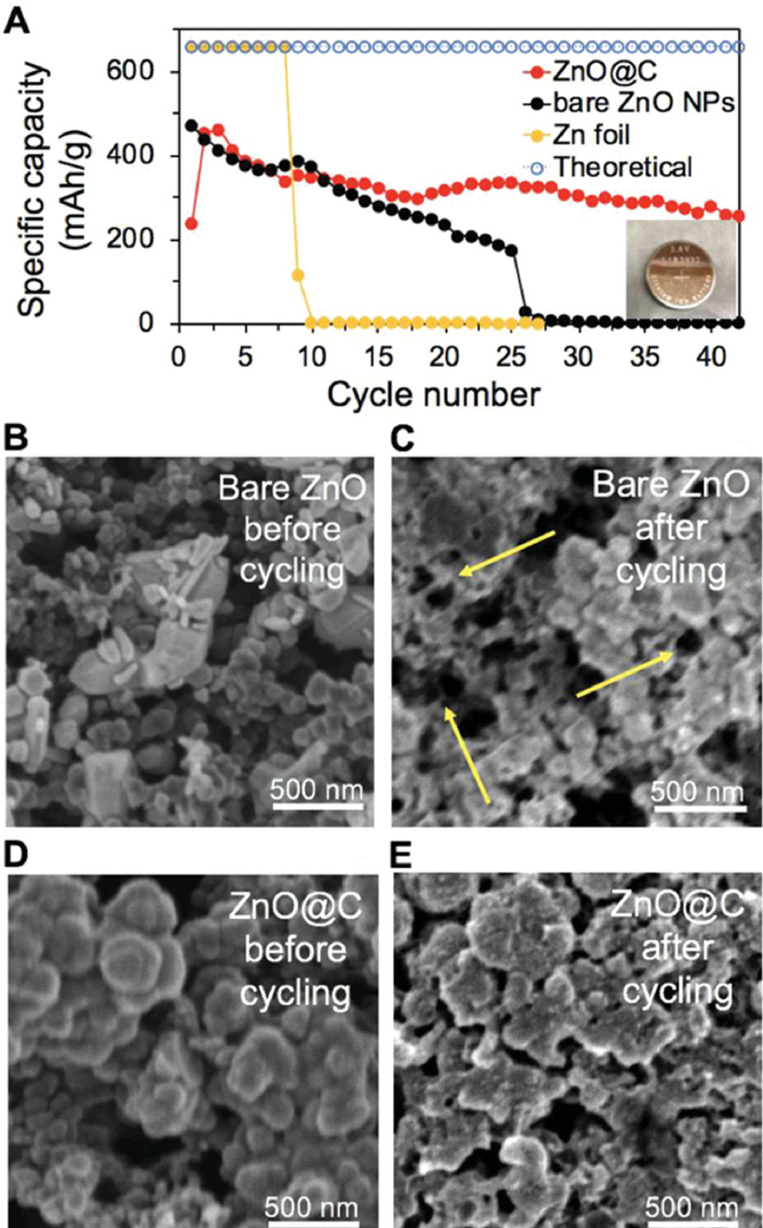
Figure 9. ( A ) Specific discharge capacity of uncoated ZnO, zinc foil and ZnO@C anodes over the discharge process. SEM micrograph of uncoated ZnO anode ( B ) before cycling, ( C ) after three cycles, holes are shown by yellow arrows. SEM micrograph of ZnO@C anode ( D ) before cycling and ( E ) after three cycles [46]. Reprinted with permission from Ref. [46], Copyright 2018, John Wiley and Sons.